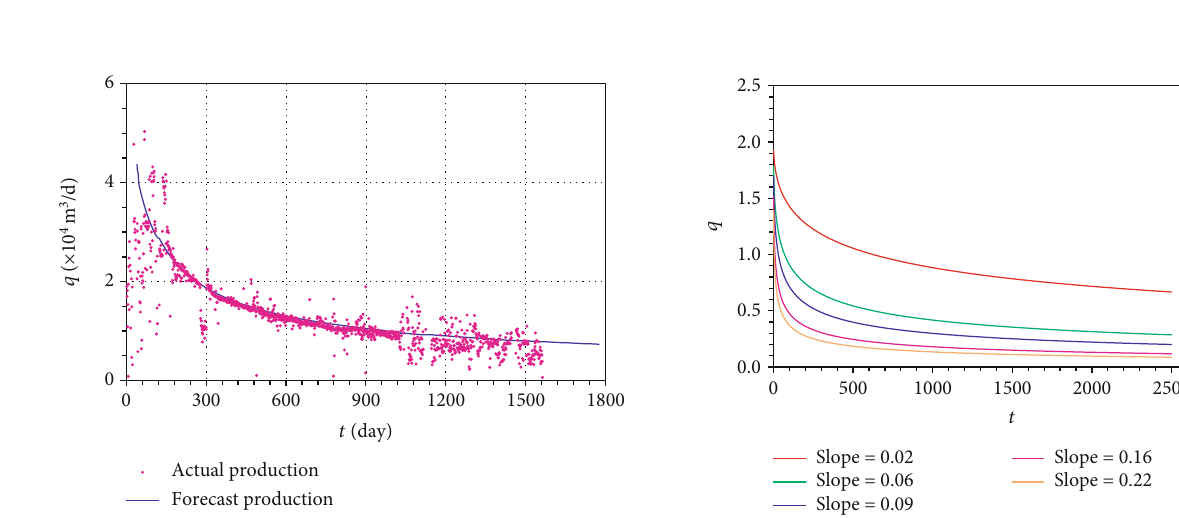
Figure 13: Cases with varied slope same intercept.